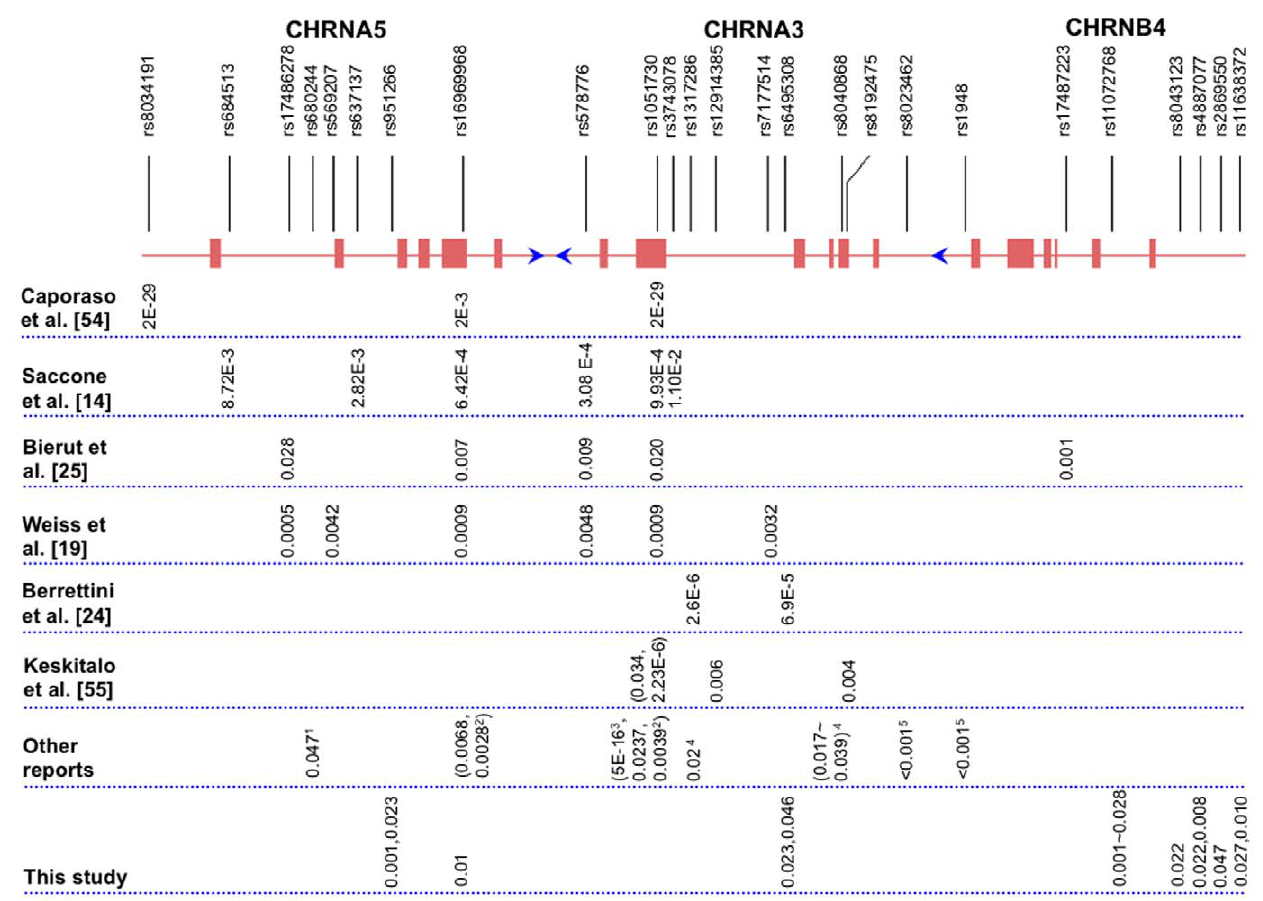
Figure 2. A summary of all reported SNPs that have been significantly associated with different smoking behaviors. Of these reported studies mentioned in the figure, most were investigated on nicotine dependence except that the study authored by Keskitalo et al. [55] was on serum cotinine level and that by Schlaepfer et al. [23] was on smoking initiation.